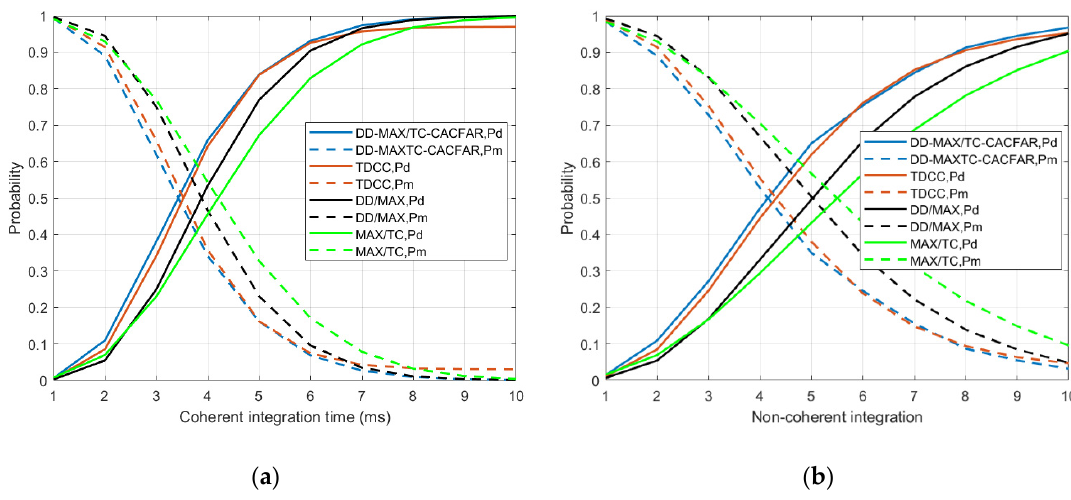
Figure 15. ( a ) P d and P m versus CIT (P fa = 0.001, SNR = − 36 dB, N nc = 2); ( b ) P d and P m versus NCT Figure 15. ( a ) P (cid:2914) and P (cid:2923) versus CIT ( P (cid:2916)(cid:2911) = 0.001 , SNR= − 36dB, N (cid:2924)(cid:2913) = 2 ); ( b ) P (cid:2914) and P (cid:2923) versus (P fa = 0.001, SNR = − 36 dB, CIT = 2 NCT ( P (cid:2916)(cid:2911) = 0.001 , SNR= − 36dB, CIT=2ms).